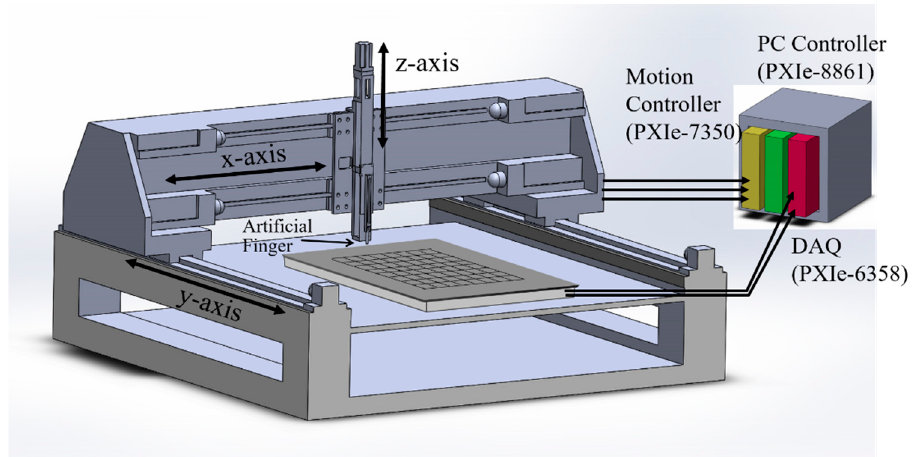
Figure 6. Collection of training data for Lamb-wave touchscreen using artificial gelatin finger carried by three-axis (x–y–z) automatic stage integrated with PC-based data acquisition system.